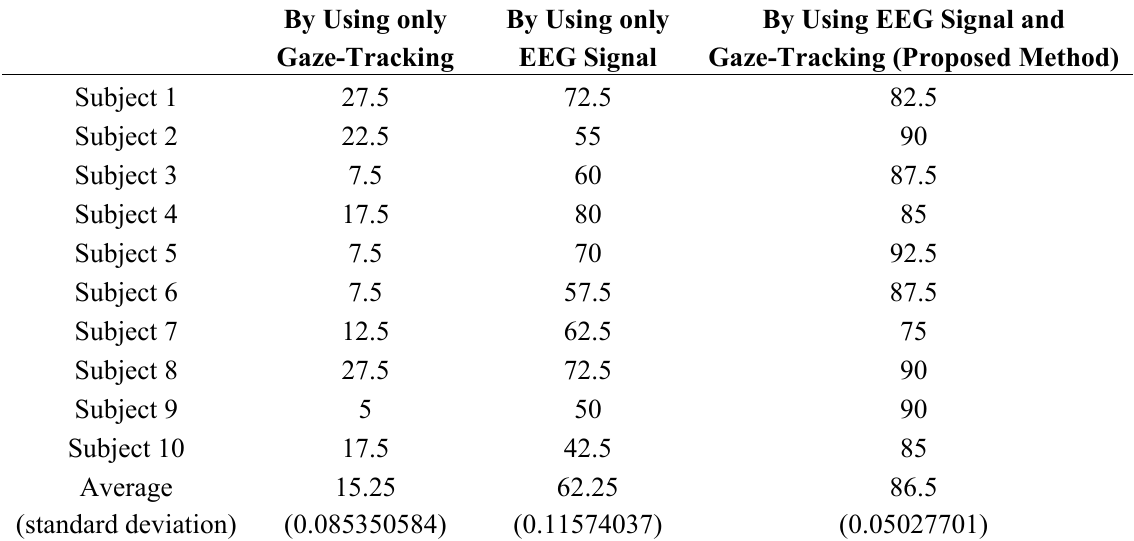
Table 2. Comparisons of the accuracies of three methods of Figure 5 (unit: %). By Using